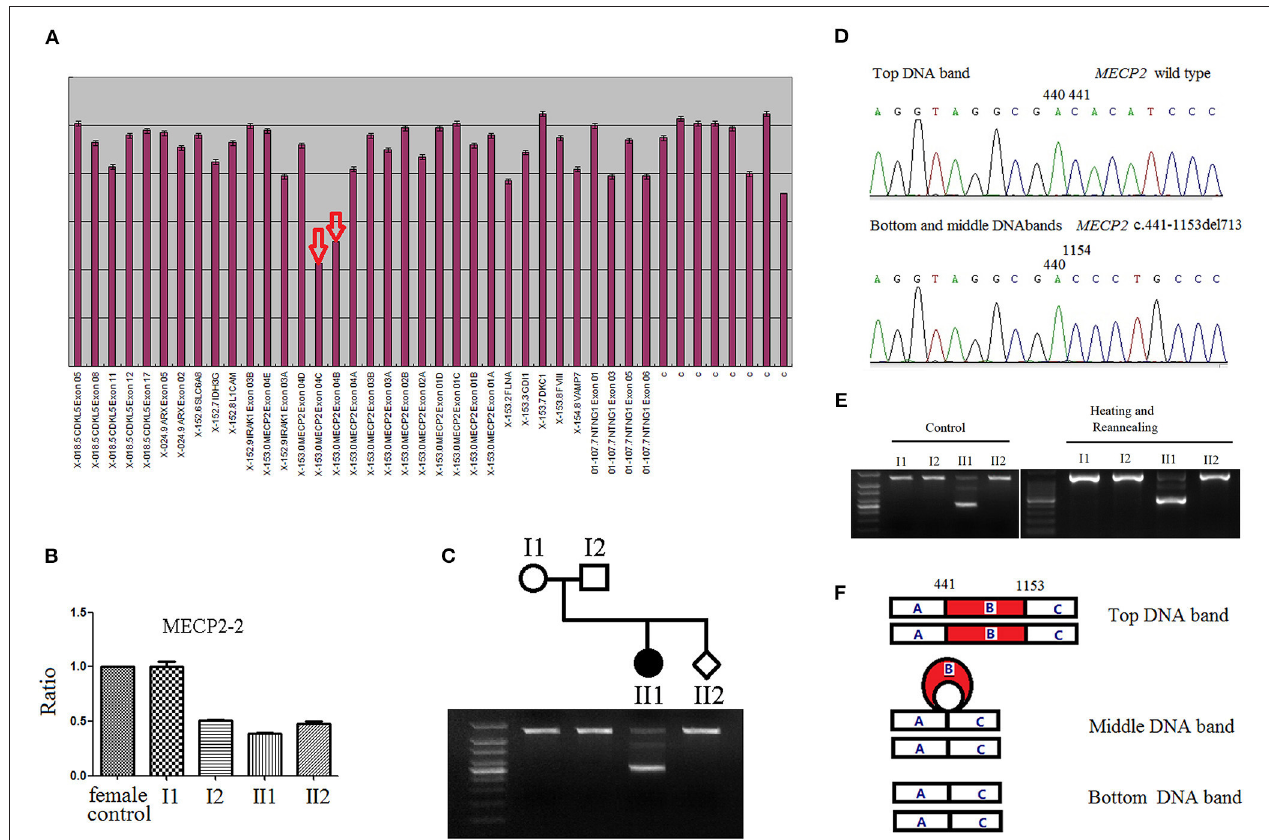
FIGURE 1 | (A) Detection of MECP2 exon alterations via multiplex ligation-dependent probe amplification (MLPA). The arrows illustrate the presumed deletions, as the area of the peaks from the female proband DNA is approximately half that of the female controls. (B) The MECP2 amplicon with MECP2 -real time quantitative PCR-2 primers to narrow down the deletion breakpoints and determine the results of MLPA. MECP2 relative amount of female proband, and male fetus were half that of female control. (C) The products of long-range PCR were analyzed with 1.5% agarose gel electrophoresis. The PCR product from the proband showed three DNA bands, whereas PCR product bands of the proband’s parents and the fetus, were single. (D) Three DNA bands of long-range PCR from the proband were separately cut, T-A cloned, and finally sequenced after plasmid extraction. The sequence of top DNA band was wild type; both, bottom and middle DNA bands show 713-base pairs deletion in exon 4 (c.441_1153del713), and the single band of proband’s parents and the fetus were of the wild type. (E) There was no difference between the PCR products untreated (left) and treated with heating and reannealing (right) in electrophoresis analysis. The treated PCR products were denatured at 95 ◦ C for 3min, followed by gradual reannealing for 30min with a temperature ramp of − 1 ◦ C/min to optimize for the formation of heteroduplexes and homoduplexes. (F) Schematic diagram of three DNA bands after PCR. The top DNA band was homoduplex of wild type, the bottom DNA band was homoduplex of mutant type, the middle DNA band was heteroduplex of wild type and mutant type. Part B (red): 713-base pairs deletion in exon 4 (c.441_1153del713) of